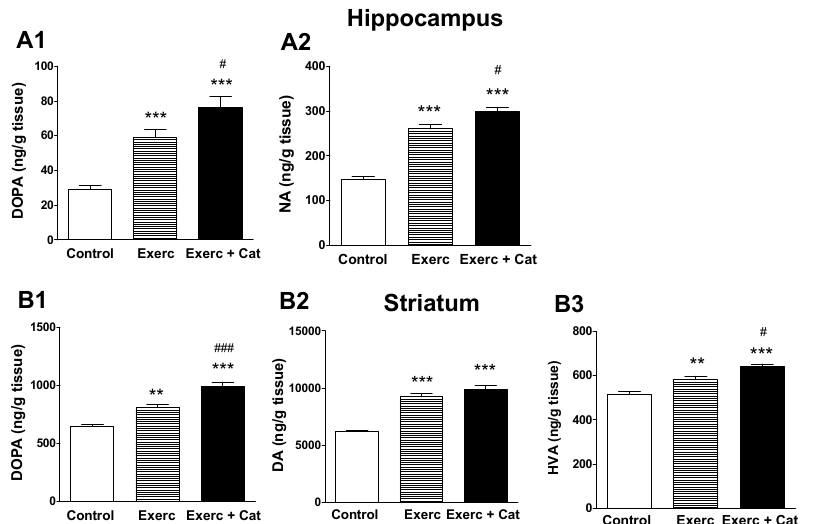
Figure 4. Effect of exercise and the combined action of exercise and catechin treatment on TH enzyme activity in the hippocampus ( A ) and striatum ( B ) of old rats. Bars represent the mean ± SEM of DOPA accumulation (after in vivo inhibition of decarboxylation with NSD-1015) ( A1 ) and NA levels ( A2 ) in extracts from the hippocampus, DOPA accumulation ( B1 ) and DA levels ( B2 ) as well as its metabolite HVA ( B3 ) in extracts from the striatum of animals subjected to exercise (Exerc, n = 7) and the exercise plus catechin treatment group (Exerc + Cat, n = 7) versus animals in the control group ( n = 7). ( A ) One-way ANOVA detected a significant effect on DOPA (F(2,18) = 30.51, p < 0.0001) and NA (F(2,18) = 88.83, p < 0.0001) in the hippocampus. ( B ) One-way ANOVA detected a significant effect on DOPA (F(2,18)=41.41, p < 0.0001), DA (F(2,18) = 63.07, p < 0.0001) and HVA (F(2,18) = 25.32, p < 0.0001) in the striatum. ** p < 0.01, *** p < 0.001 comparing with the control group; # p < 0.05, ### p < 0.001 comparing both exercise groups with each other (one-way ANOVA, followed by Bonferroni).